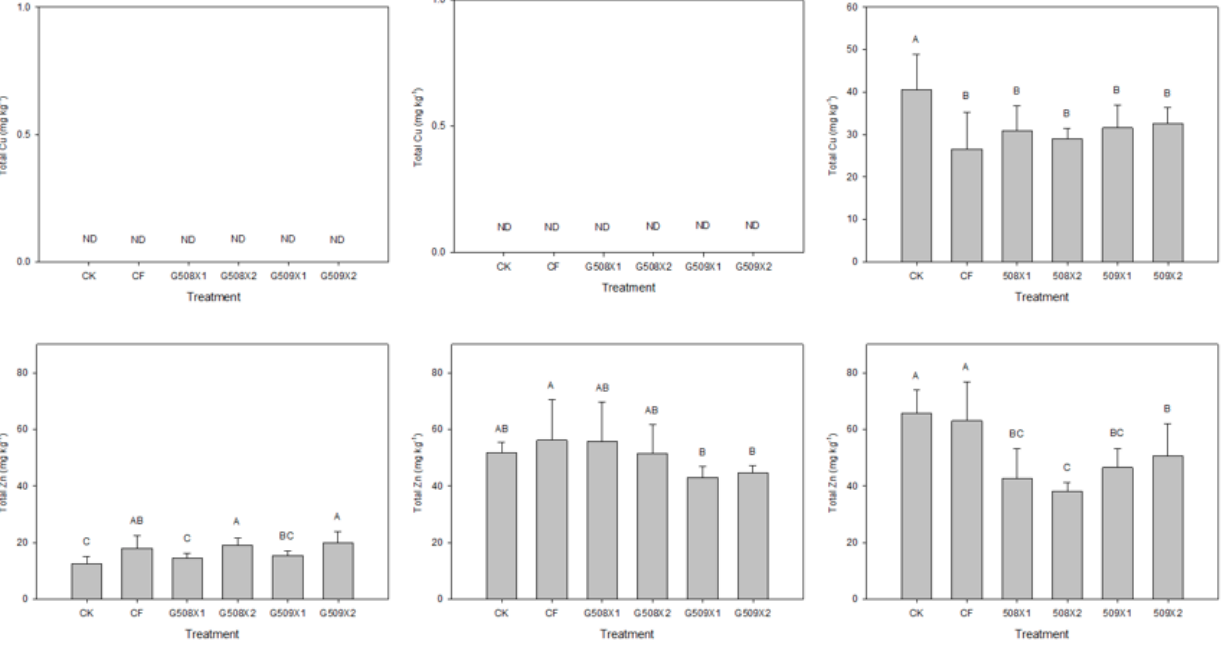
Figure A3. The total concentrations of Cu and Zn of the three crops under different treatments: cabbage ( left ), Chinese cabbage ( middle ), and water spinach ( right ). The different letters indicate the significance among the treatments obtained through one-way ANOVA analysis (Duncan test, p < 0.05, n = 4). The codes have the same meanings as those in Figure 1.